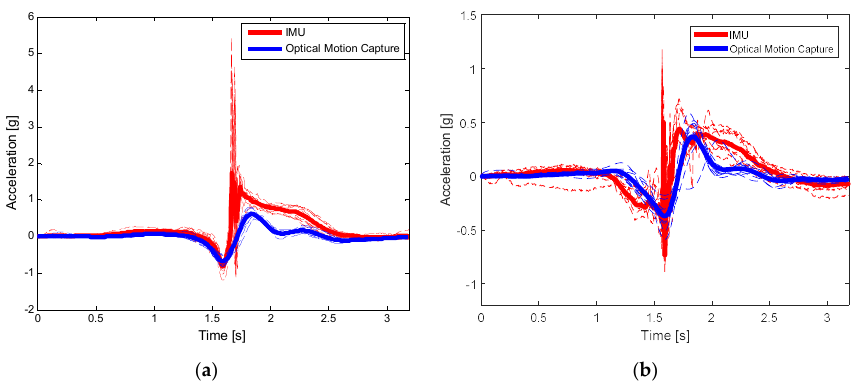
Figure 4. Inertial measurement unit (IMU) sensor and optical motion capture acceleration signals superimposed for 10 soccer heading impacts. ( a ) IMU located on the head ( b ) IMU sensor located at T3. Data obtained from participant used in motion capture heading tests.